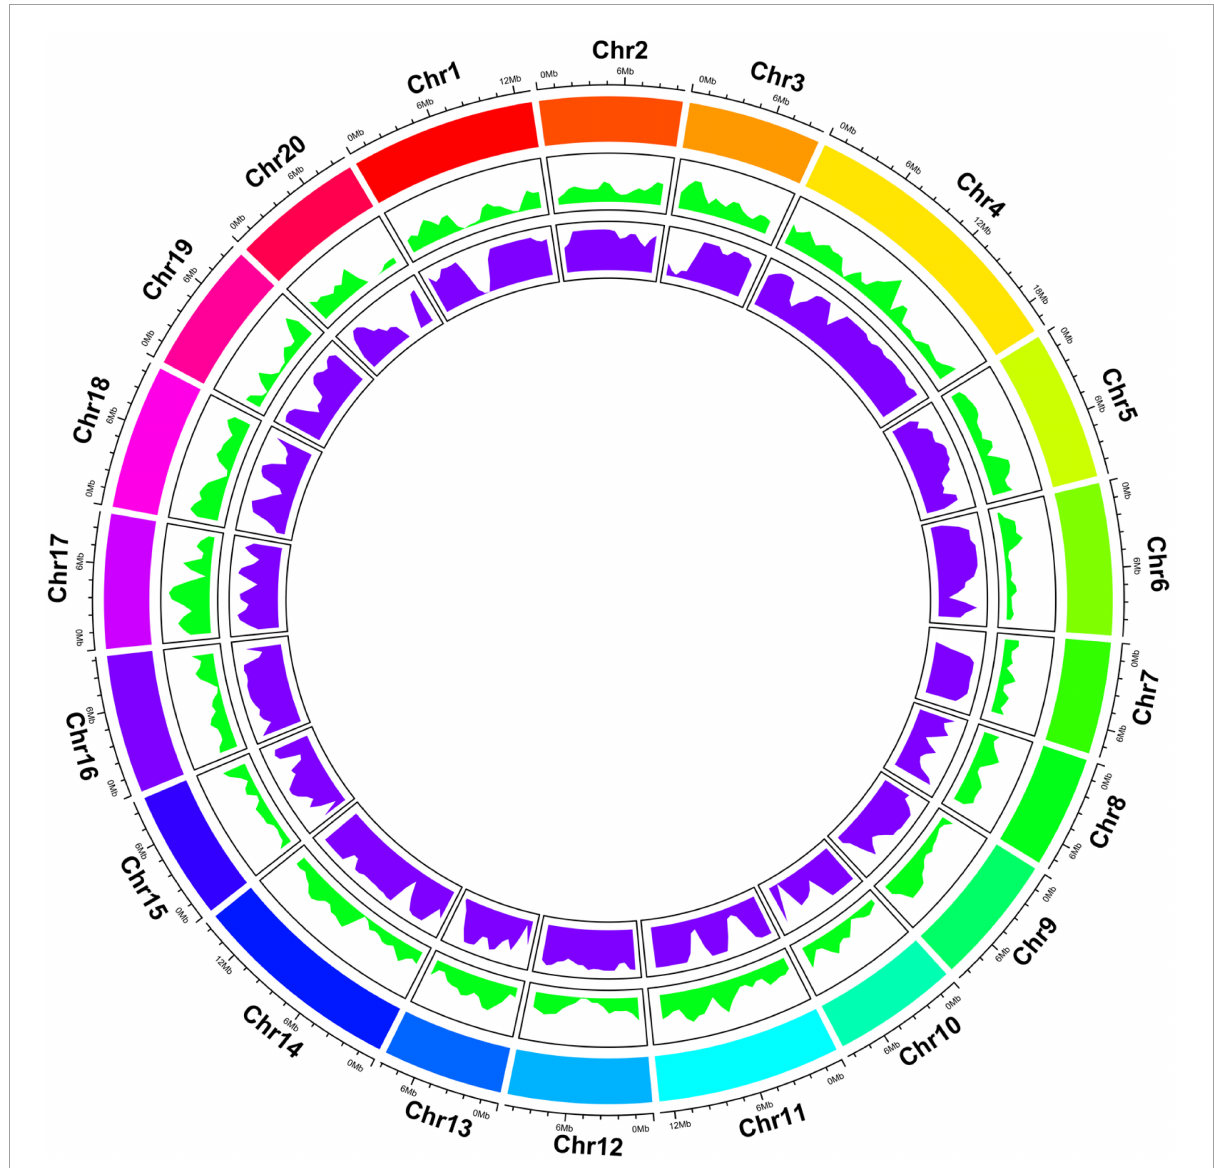
FIGURE2 Overview of the Genome-wide resequencing among two parents (AG and Hubbard) and 102 F 2 plants. Tracks from outside to inside: Chromosome numbers and lengths, Single Nucleotide Polymorphisms (SNPs) and